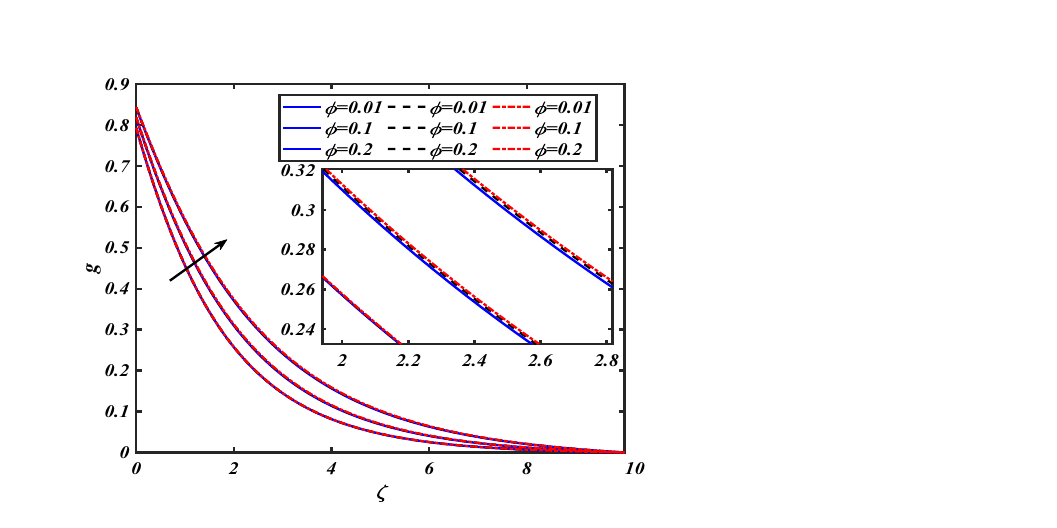
Figure 9. Pictogram of φ via g .